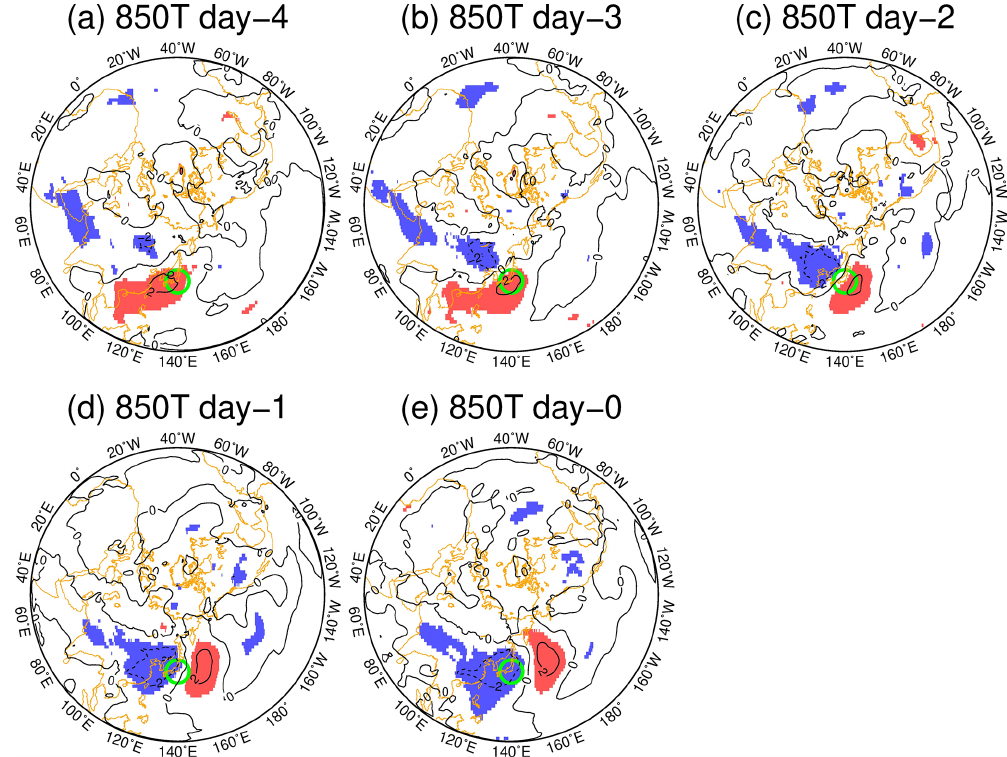
Figure 7. Composite daily mean 850hPa temperature ( ◦ C) from day 4 to day 0 for 1968/69–1979/80. The contour interval is 2 ◦ C, and the red and blue shading denotes positive and negative anomalies significant at the 95% confidence level, respectively, based on a two-tailed Student’s t test. A green circle indicates the position of Japan.